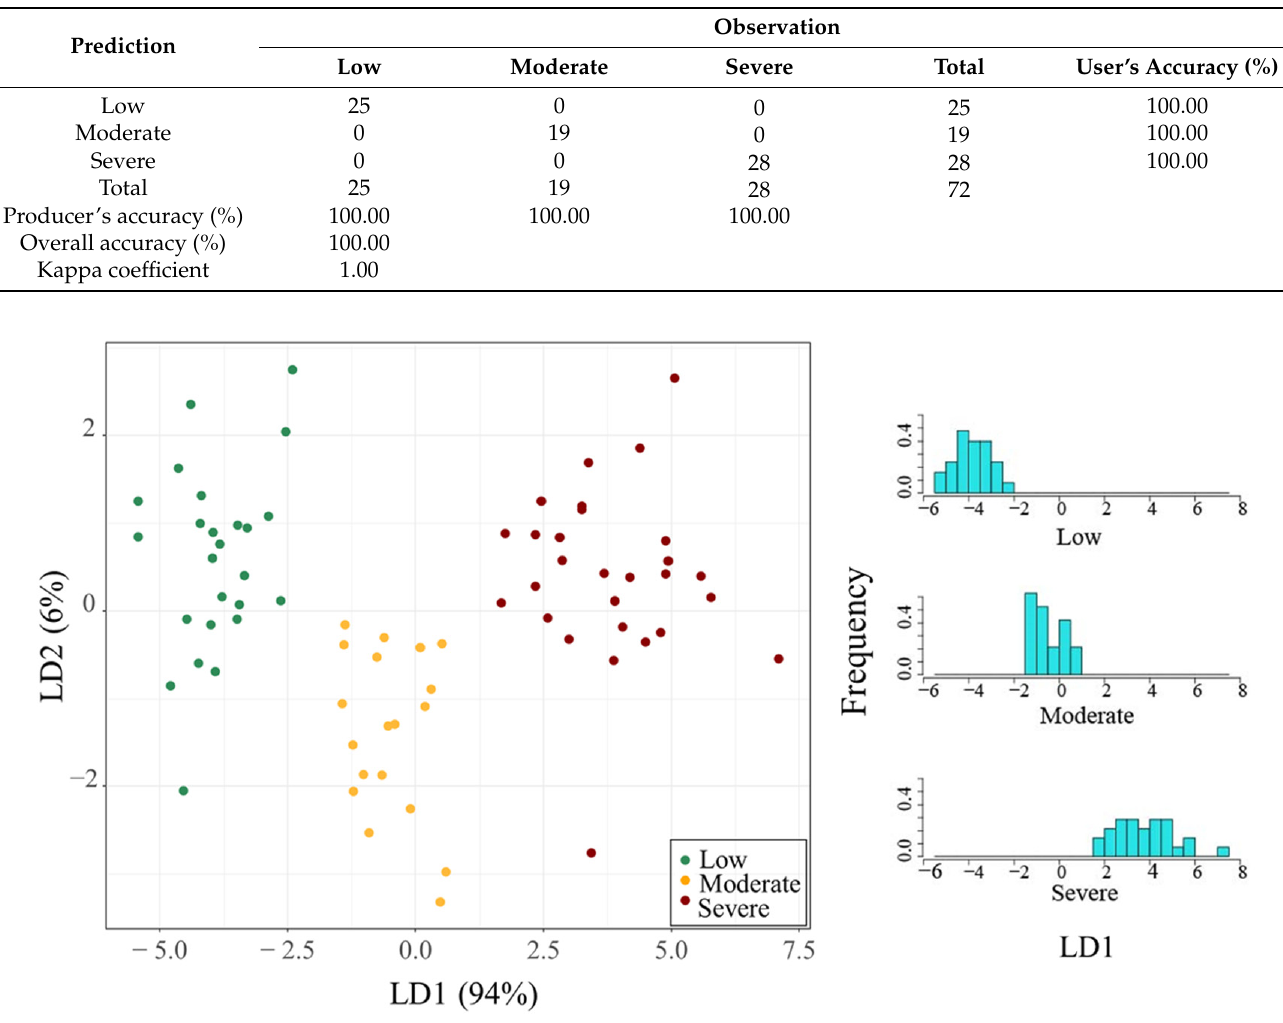
Figure 6. Classification of three erosion intensity classes based on linear discriminant analysis (LDA) of PC scores derived from Sentinel-2 bare soil spectra. Histograms on the right show the distribution of the first LD function’s value for the three classes. Table 2. Confusion matrix of Sentinel-2-based spectral classification of erosion intensity using a combination of principal component and linear discriminant analysis (PCA-LDA).